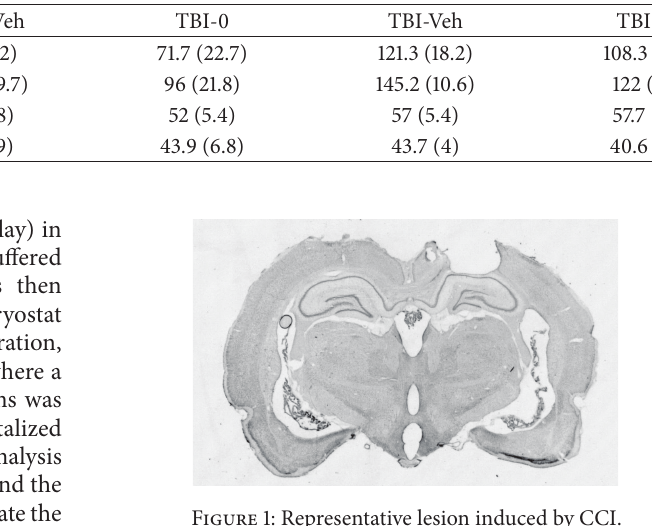
Table 1: Mean values (SEM) of the total exploration times (s) in the neophobia, acquisition, and retention sessions for each experimental group.